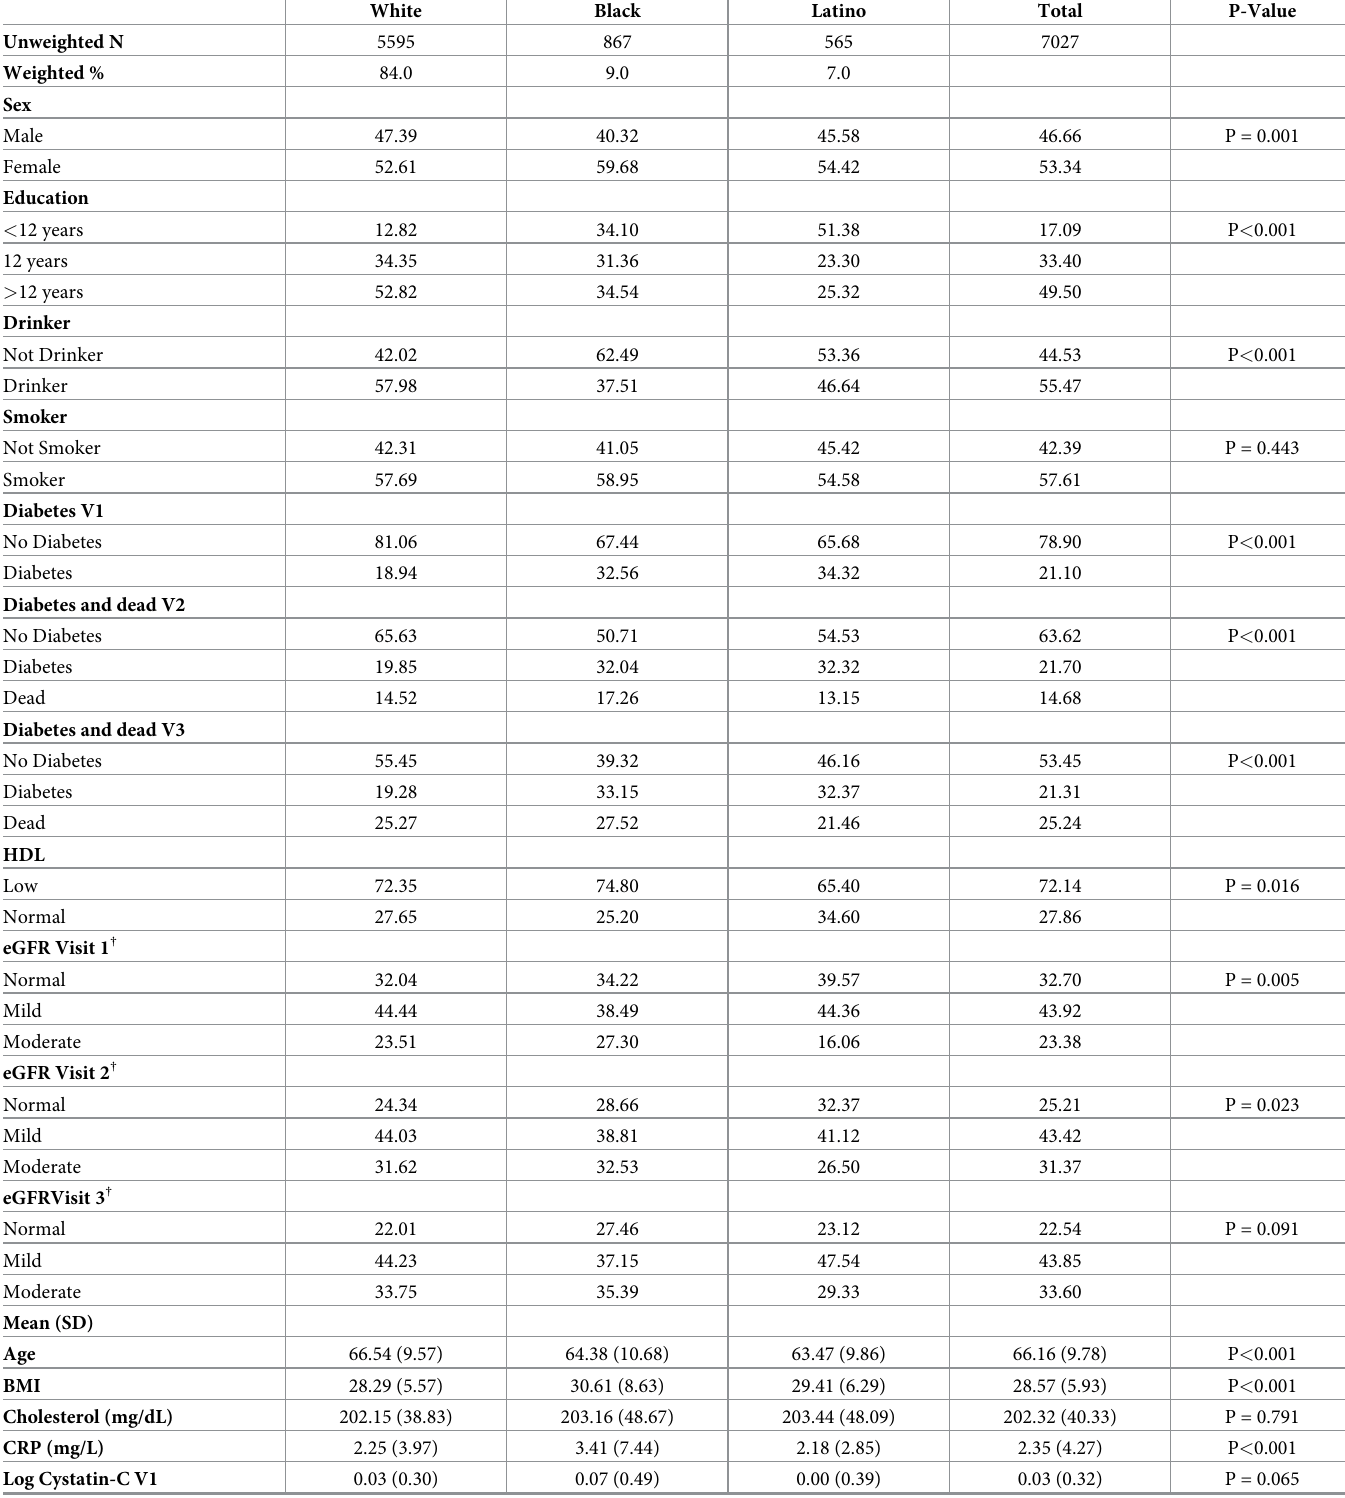
Table 1. Descriptive characteristics by